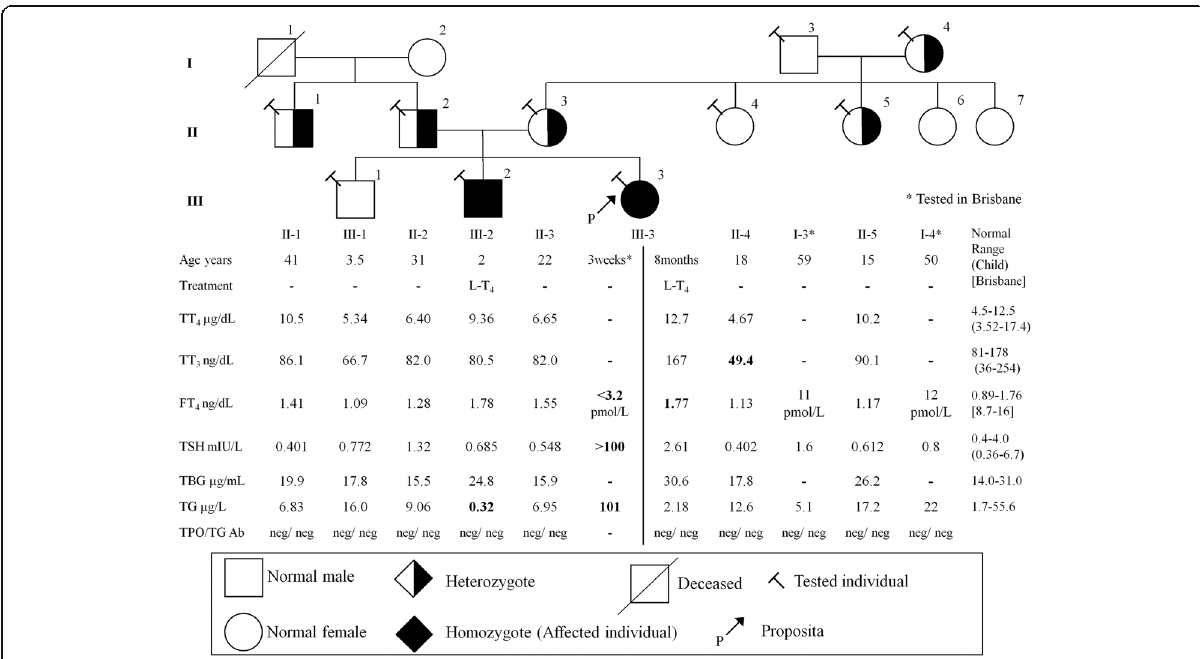
Fig. 2 Pedigree of the family and results of thyroid function tests. Each generation corresponds to a roman number. Arabic numbers above each symbol identify the subjects. Laboratory data are aligned below each symbol. Abnormal values are in bold type. Abbreviations: L-T 4 ; levothyroxine, TT 4 ; total thyroxine, TT 3 ; total triiodothyronine, FT 4 ; free thyroxine, TSH; thyroid-stimulating hormone, TBG; thyroxine binding globulin, TG; thyroglobulin, TPO Ab; anti-TPO antibody, TG Ab; anti-thyroglobulin antibody. The International System of Units: TT 4 ; μ g/dL=12.87 nmol/L, TT 3 ; ng/dL=0.0154 nmol/ L, FT 4 ; ng/dL=12.87 pmol/L, TBG; μ g/mL =0.0185 μ